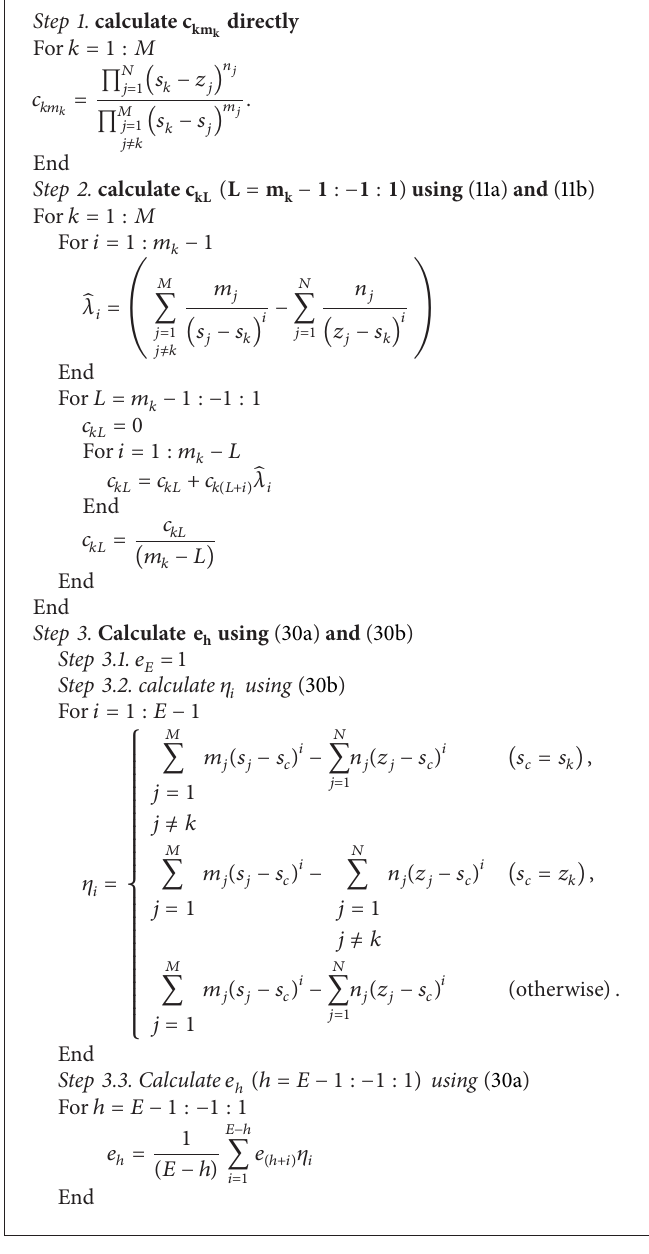
Algorithm 1: Algorithm for factorized